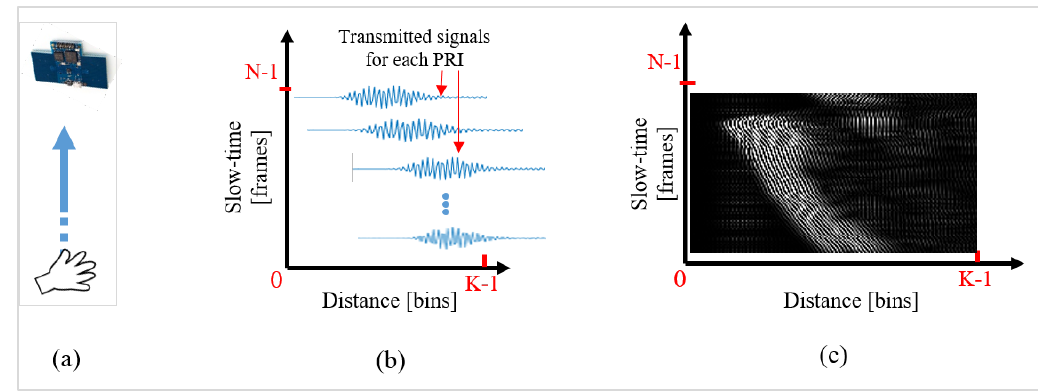
Figure 5. Conversion of the gesture signal to a grayscale pattern. ( a ) Experimental setup showing a hand moving towards the radar; ( b ) respective symbolic representation of individual fast-time signals; ( c ) generated grayscale image.